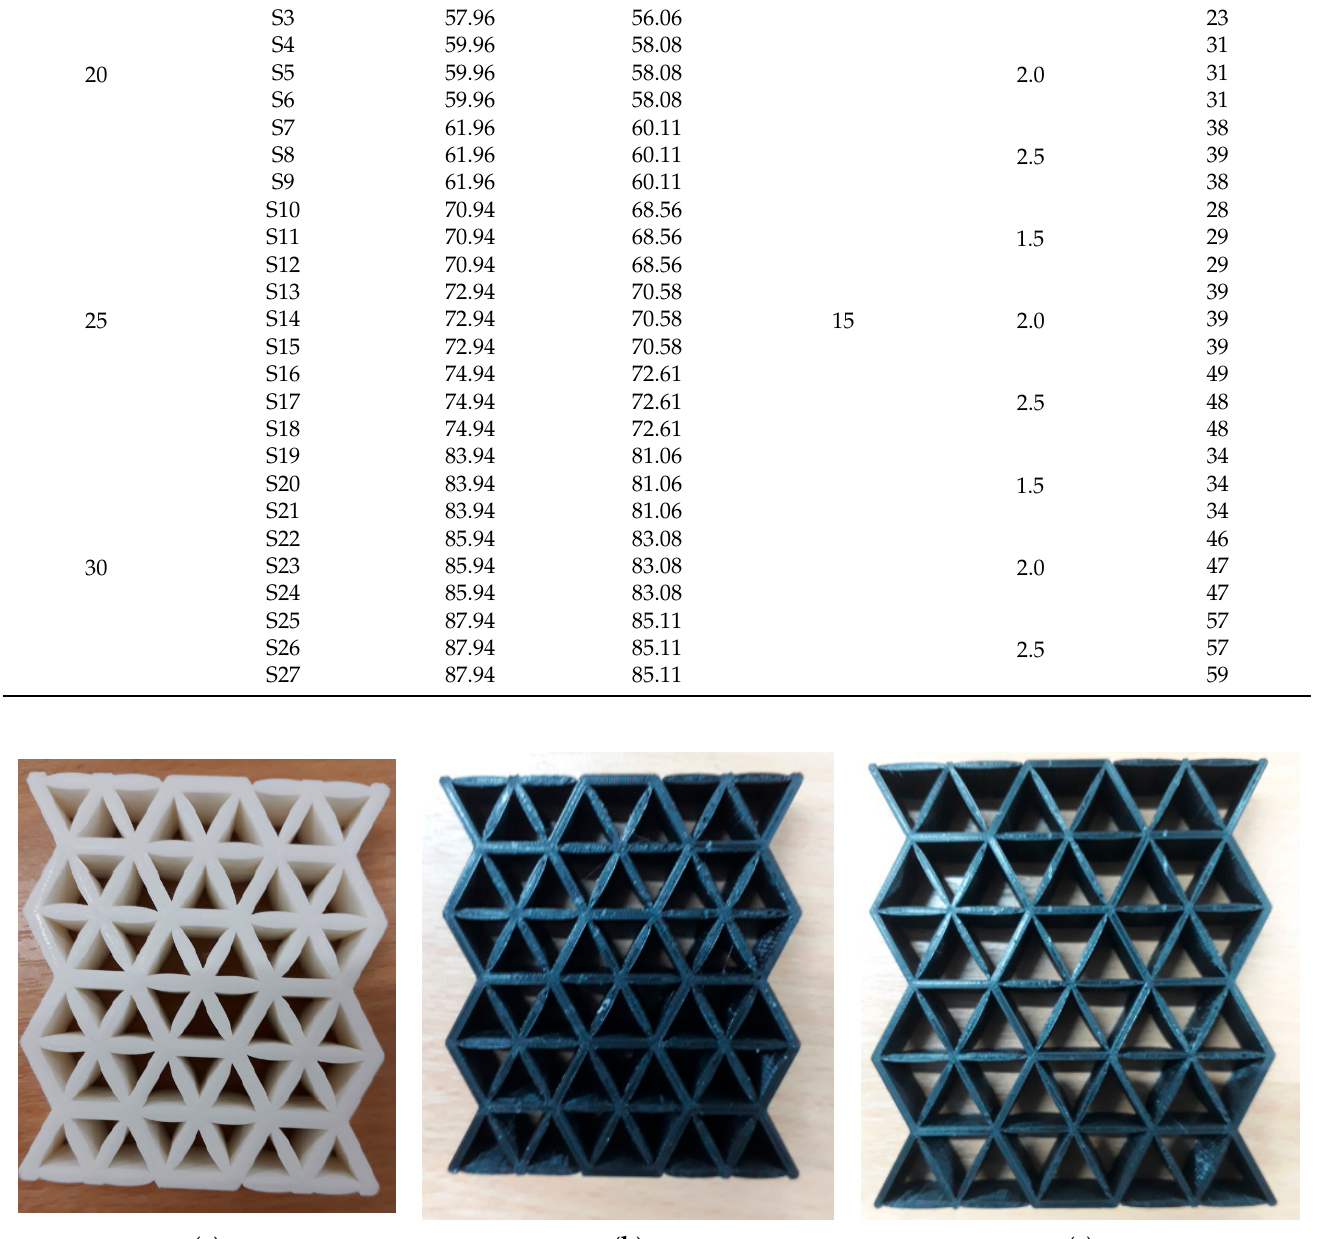
( b ) Figure 5. ( a ) Schematic of sample orientation during test. ( b ) Sample orientation during test. 3. Results and Discussion The results obtained from the compression test are plotted in the form of a load- displacement curve. The maximum peak means the maximum value of loading that the structure can resist. The value of the stress determines the strength capability of the structure. Here, the maximum peak value of the tested samples is determined from the highest value stress in the linear region. The CFE is taken from the load-displacement